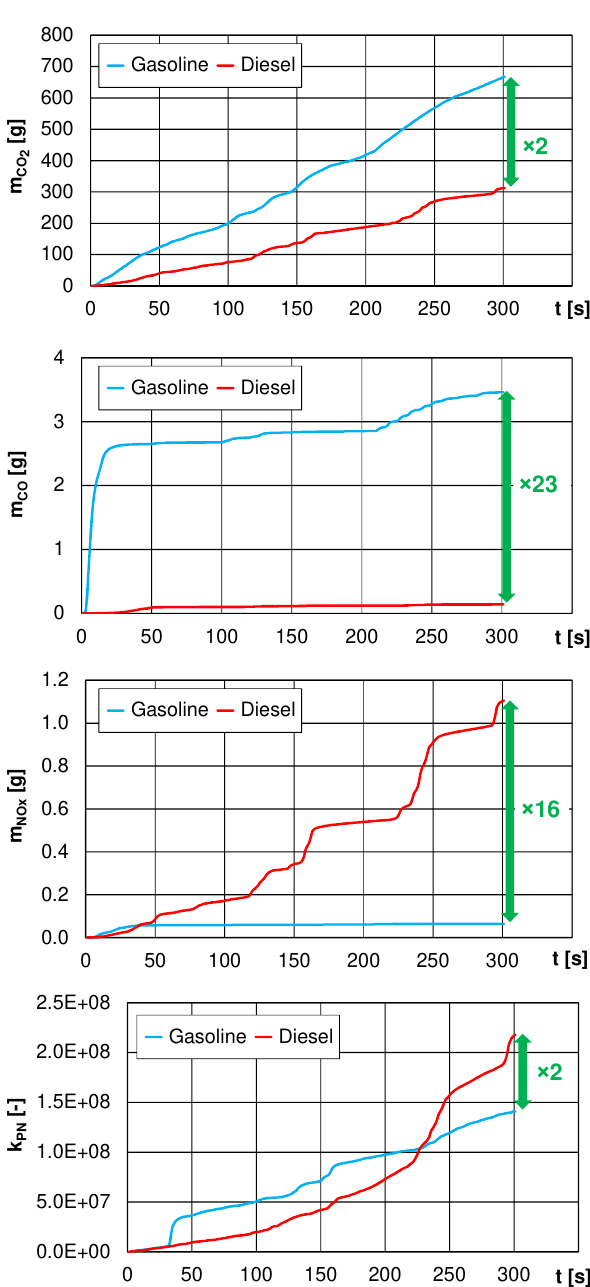
Fig. 11. The mass of carbon dioxide, carbon monoxide, nitrogen oxides and the number of particles in the cold start period of 300 s for gasoline and diesel